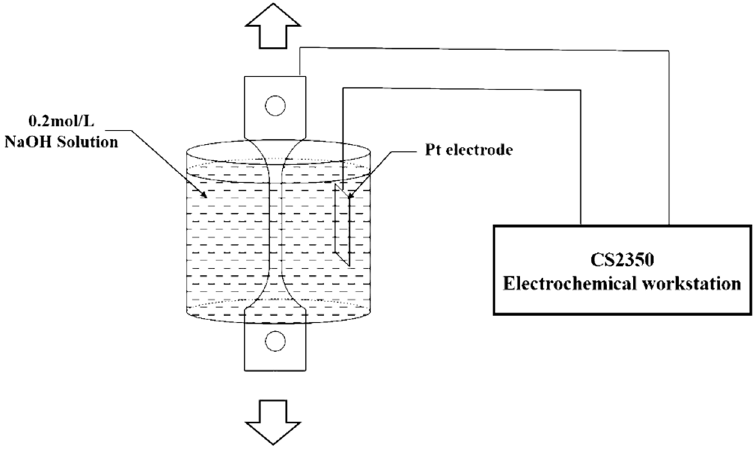
Figure 5. Schematic diagram of static hydrogen charging tensile test device.